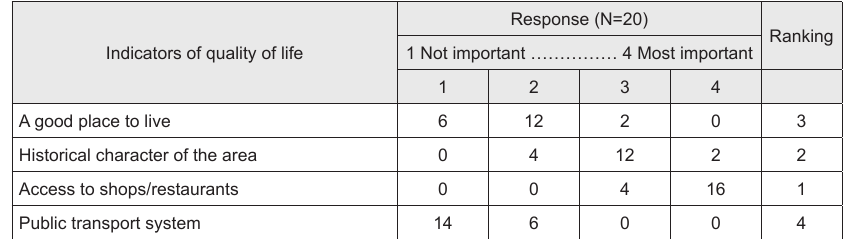
Figure 4: Most valued feature on Florida